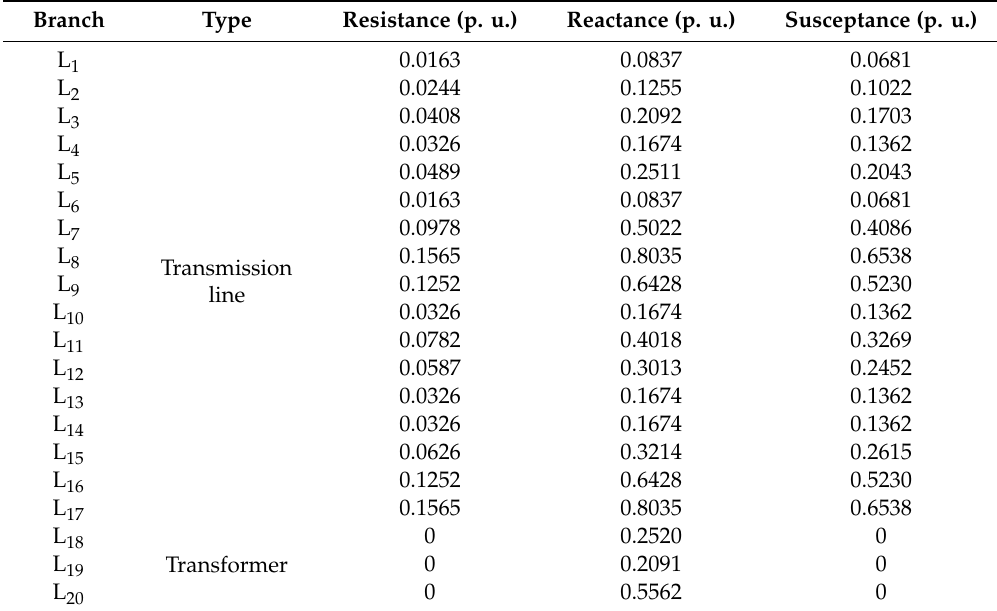
Table 3. Transmission line and transformer parameters.